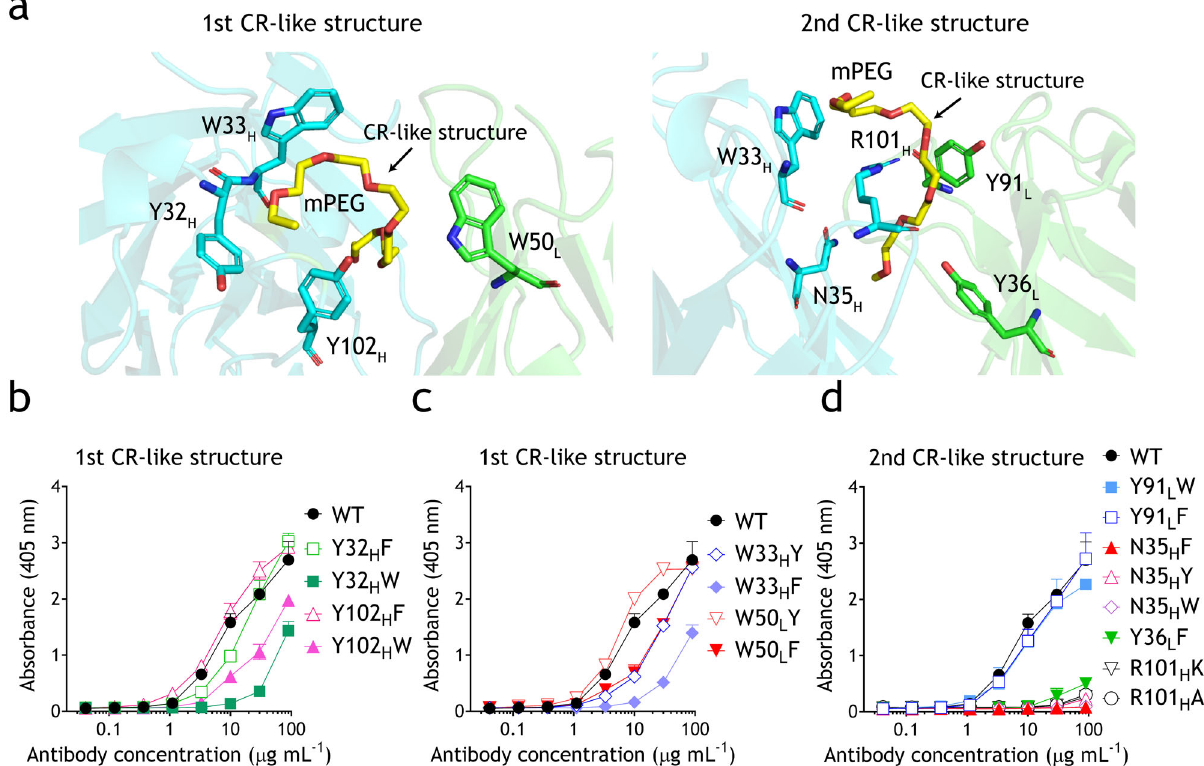
Fig. 3 Comparison of h15-2b Fab variants for mPEG interaction. a CR-like structures of mPEG and anti-mPEG h15-2b Fab complex (Light chain in green; Heavy chain in cyan). The mPEG fragment bound by h15-2b Fab is shown as a yellow stick model. b – d Microplate wells coated with mPEG 5K -NH 2 were incubated with graded concentrations of parental h15-2b or relevant variants corresponding to CR-like structures of mPEG interaction. After 1 h, the wells were washed, and antibody binding was determined by adding HRP-conjugated goat anti-human F(ab ’ ) 2 fragment speci fi c antibodies, followed by ABTS substrate. The results show the mean absorbance values (405 nm) ± standard deviation ( n = 3). The data are representative of three independent